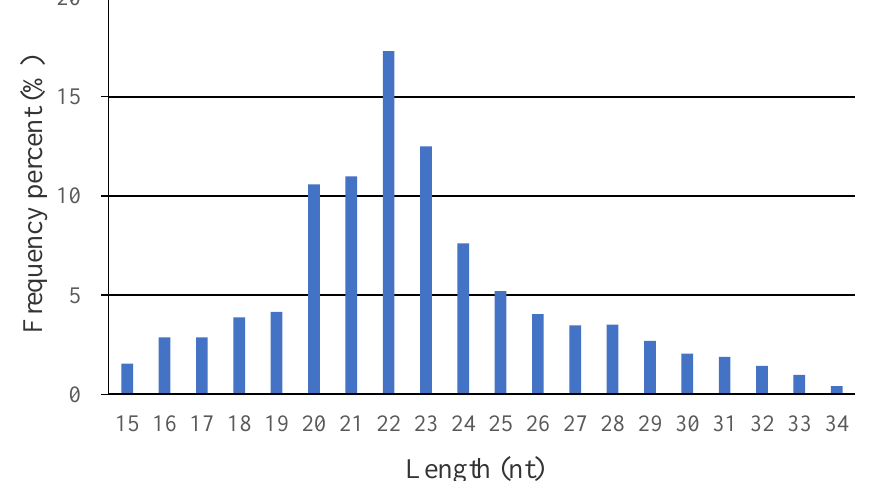
Figure 2. Length distribution of small miRNAs. Table 2. Significant DEmiRNAs ( p < 0.05). Name of the